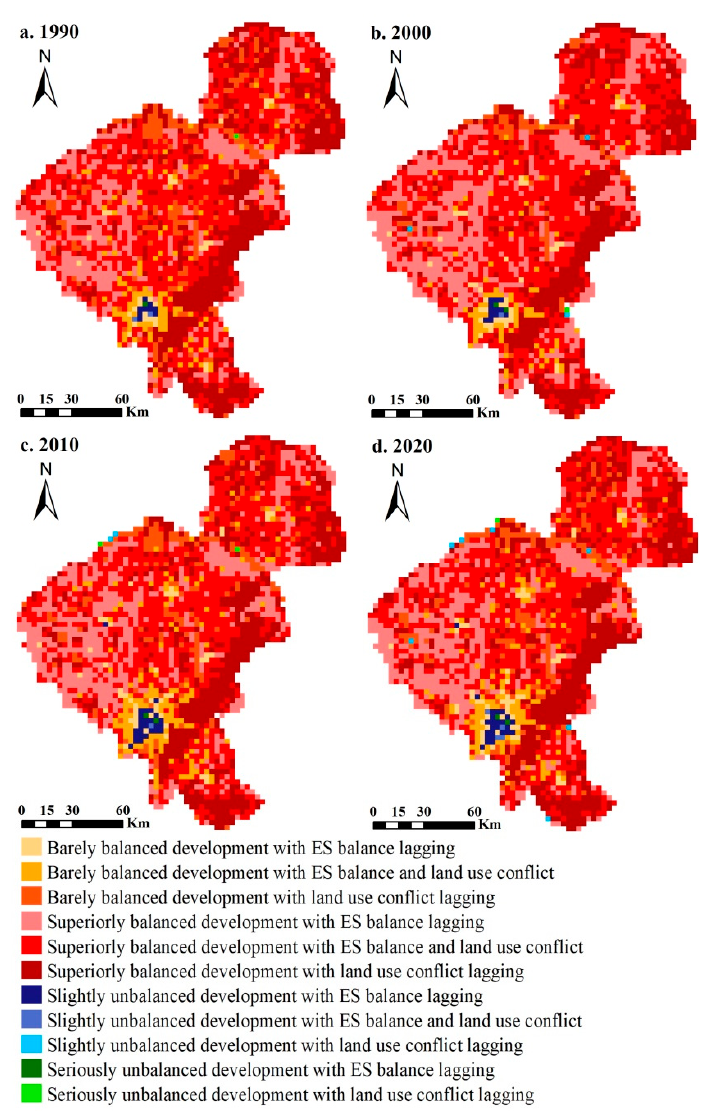
Figure 8. Spatial distribution of the coupling coordination degree of ES balance and land use conflict in 1990 ( a ), 2000 ( b ), 2010 ( c ), and 2020 ( d ), respectively.